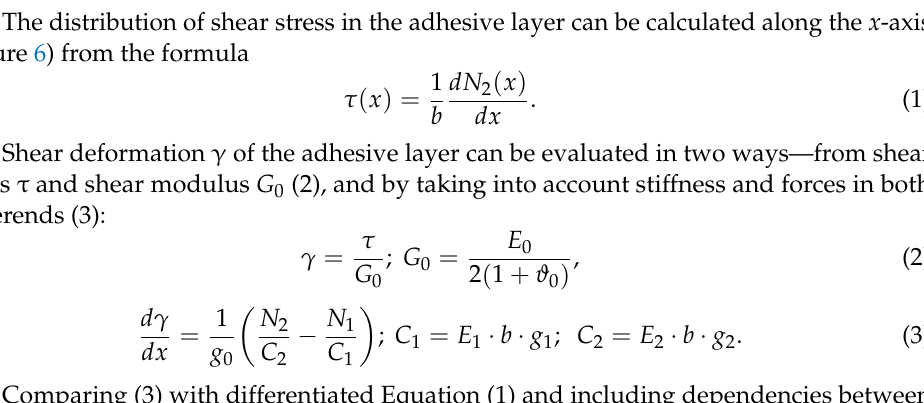
Figure 6. Double-lap joint: ( a ) geometry, dimensions and material parameters; ( b ) internal forces in investigated joint and direction of x